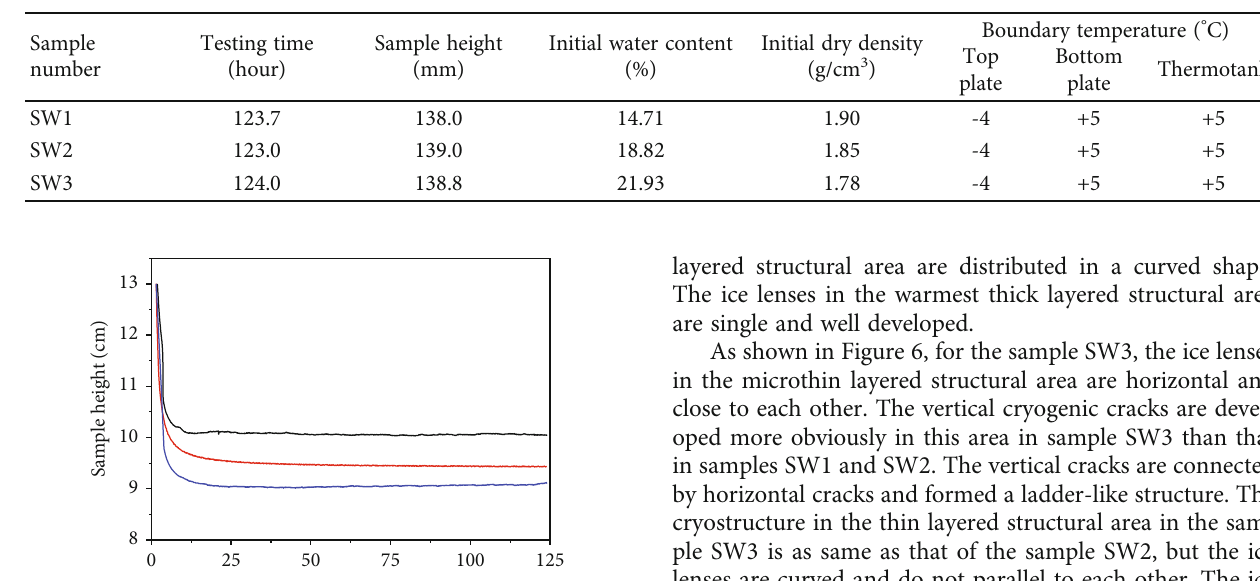
Table 2: Initial and boundary conditions of samples.